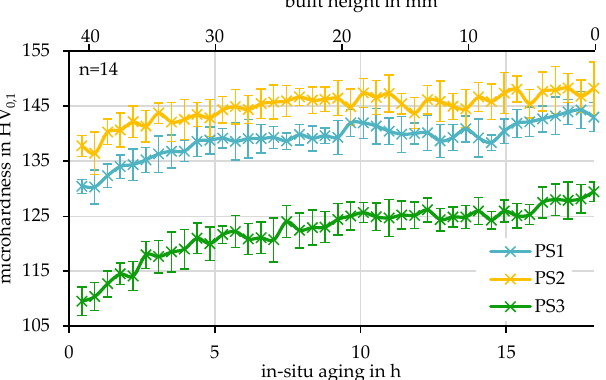
Figure 10. Effect of the in-situ aging time on the microhardness in xz.